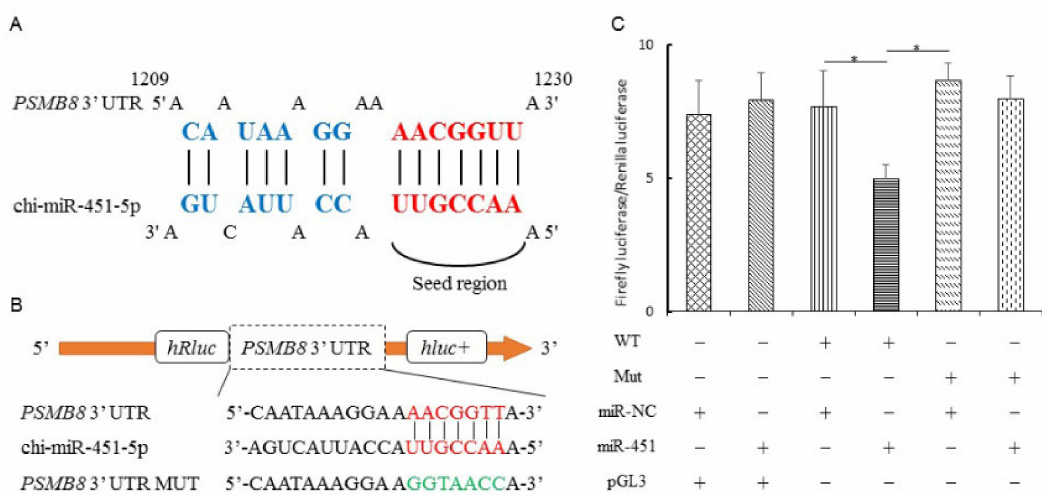
Figure 8. Chi-miR-451-5p targets the 3 (cid:48) UTR of PMSB8. ( A ) The predicted binding site of chi-miR-451-5p in the 3 (cid:48) UTR of PSMB8. ( B ) The design of luciferase reporter. PSMB8 3 (cid:48) UTR sequence contains the chi-miR-451-5p binding site; PSMB8 3 (cid:48) UTR Mut sequence has mutations of the chi-miR-451-5p binding site. ( C ) 293T cells co-transfected with luciferase reports of PMSB83 (cid:48) UTR (WT) or PMSB83 (cid:48) UTR (Mut) and chi-miR-451-5p mimics or negative control (NC) before the luciferase reporter assay. Data are shown as the mean ± SEM values ( n = 3). * p < 0.05 was considered statistically